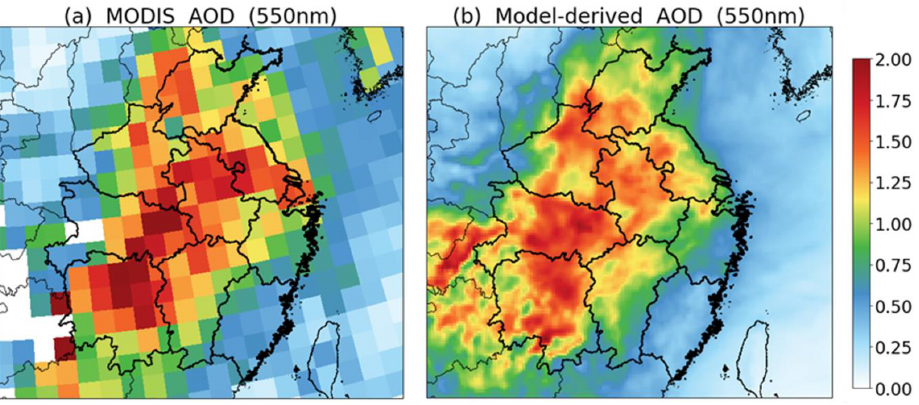
Figure 5. Spatial distributions of (a) satellite-based and (b) model-derived AODs in the OPT case over CEC for EP2. The maps were created by NCAR Command Language (NCL) (http://www.ncl.ucar.edu/, last access: 22 December